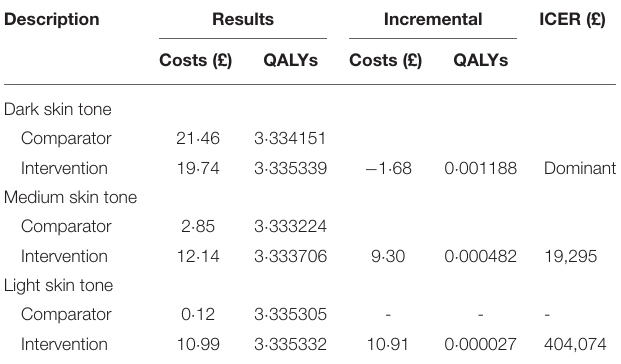
TABLE 4 | Demographic characteristics of the incidence population (observational dataset).